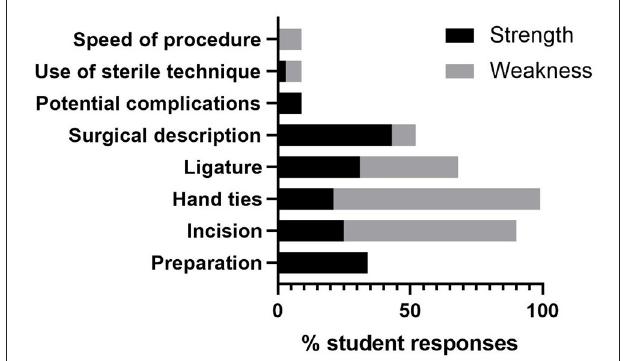
FIGURE 6 | Percent of students identifying different categories of strengths and weaknesses for their equine castration model activity. Category codes were chosen to represent themes from student self-reflections on their own castration model video.